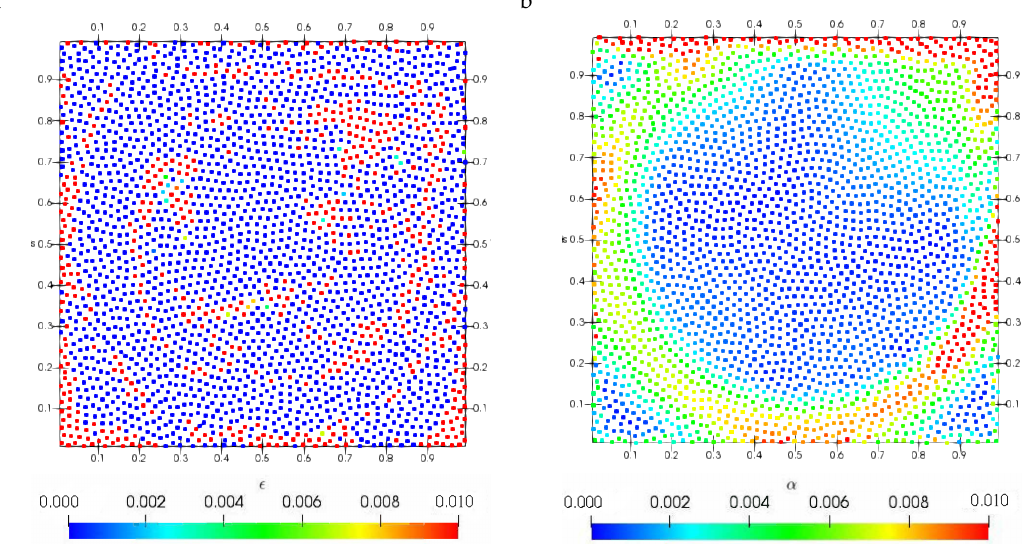
Figure 10. Lid-driven cavity flow: Results for (cid:101) and α fields for Re = 3200. Figure ( a ): Results obtained using the δ + -ADA-SPH are plotted. Figure ( b ): Results obtained using the δ + -LES-SPH [16] approach. Results computed using a resolution of 50 × 50